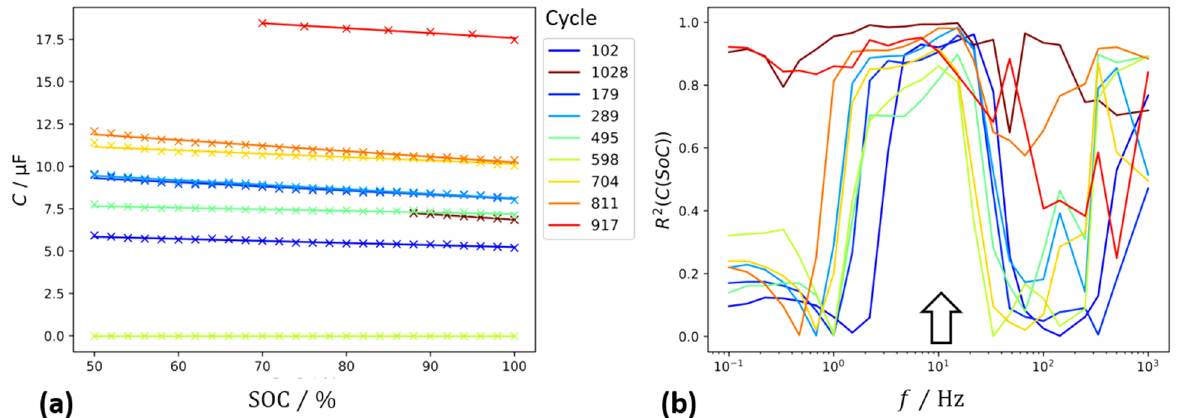
Figure 12. Cycle aging of an LCO battery (Panasonic UR18650 FK). ( a ) Linear correlation of pseudocapacitance from impedance spectra at the best frequency between 1 Hz and 100 Hz. ( b ) The coefficient of regression (fit quality) between capacitance and SOC is best around 10 Hz (see arrow). Here: SOC = actual state-of-charge of the aged battery with reference to the previous full charge.